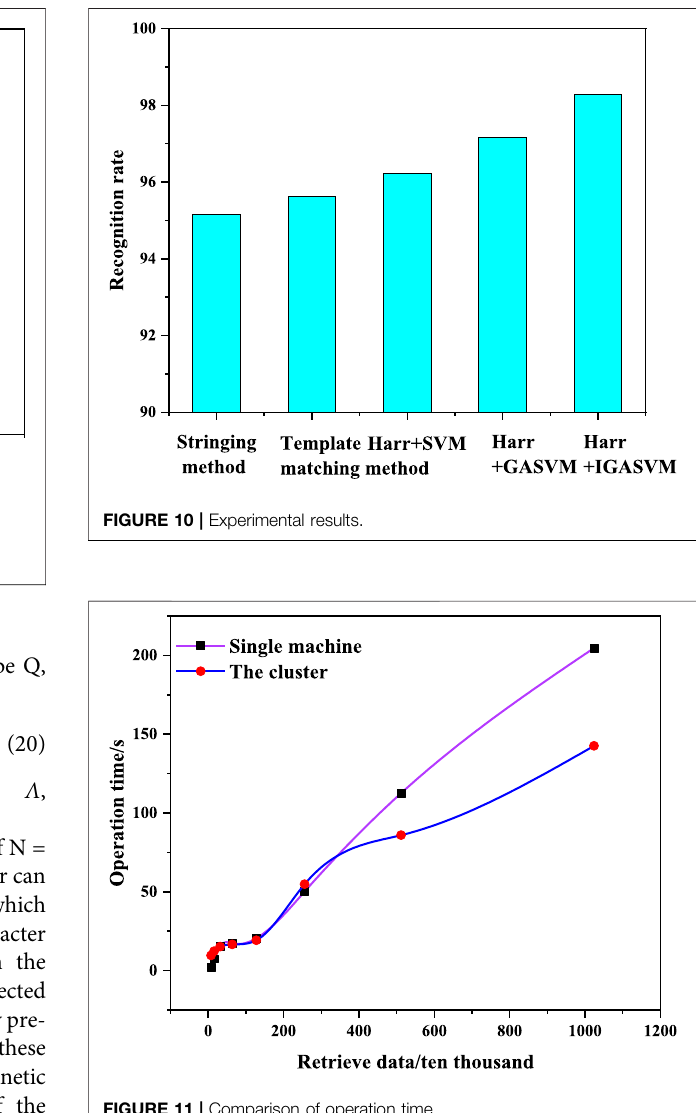
FIGURE 11 | Comparison of operation